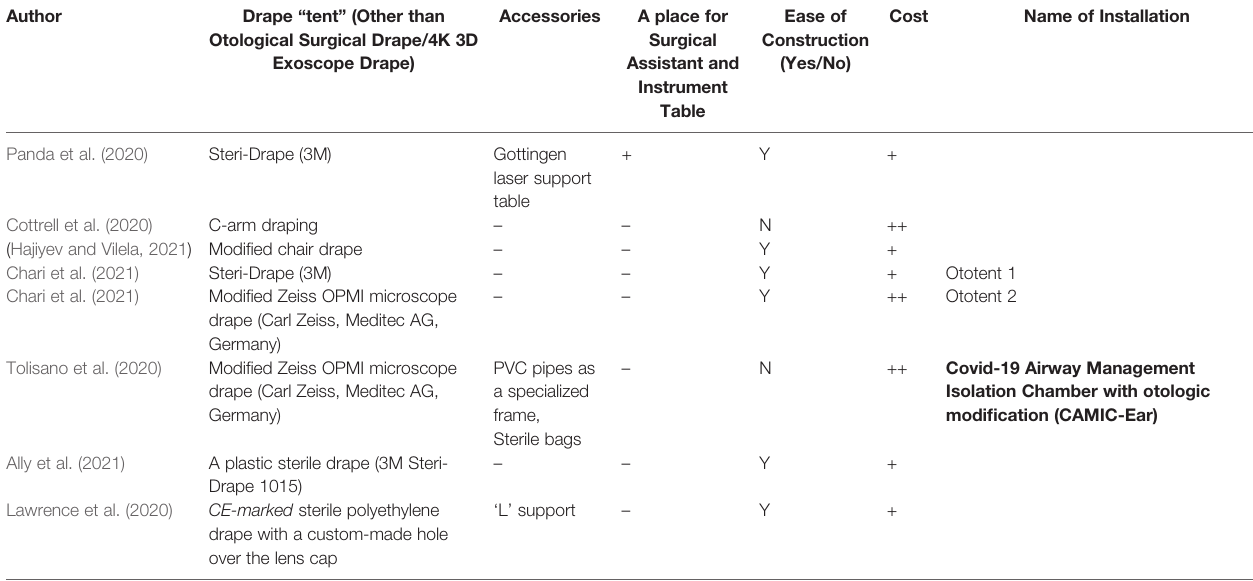
TABLE 3 | Draping techniques during otologic